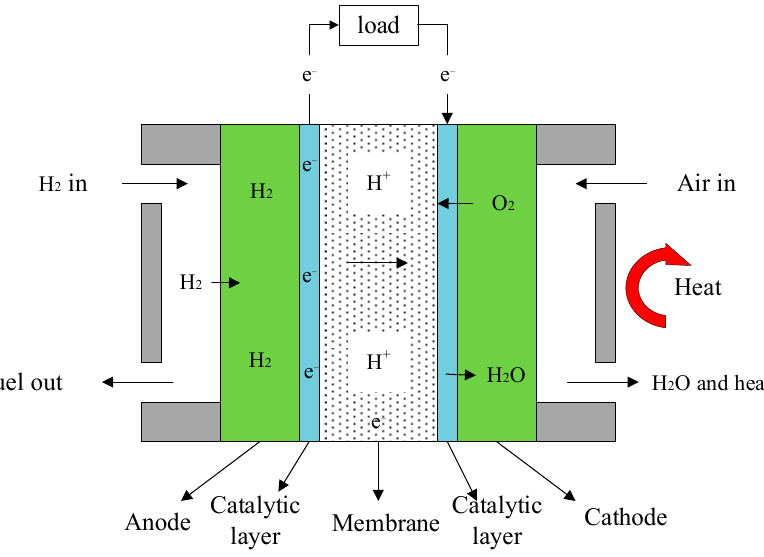
Figure 1. Working principle of HT-PEMFC.